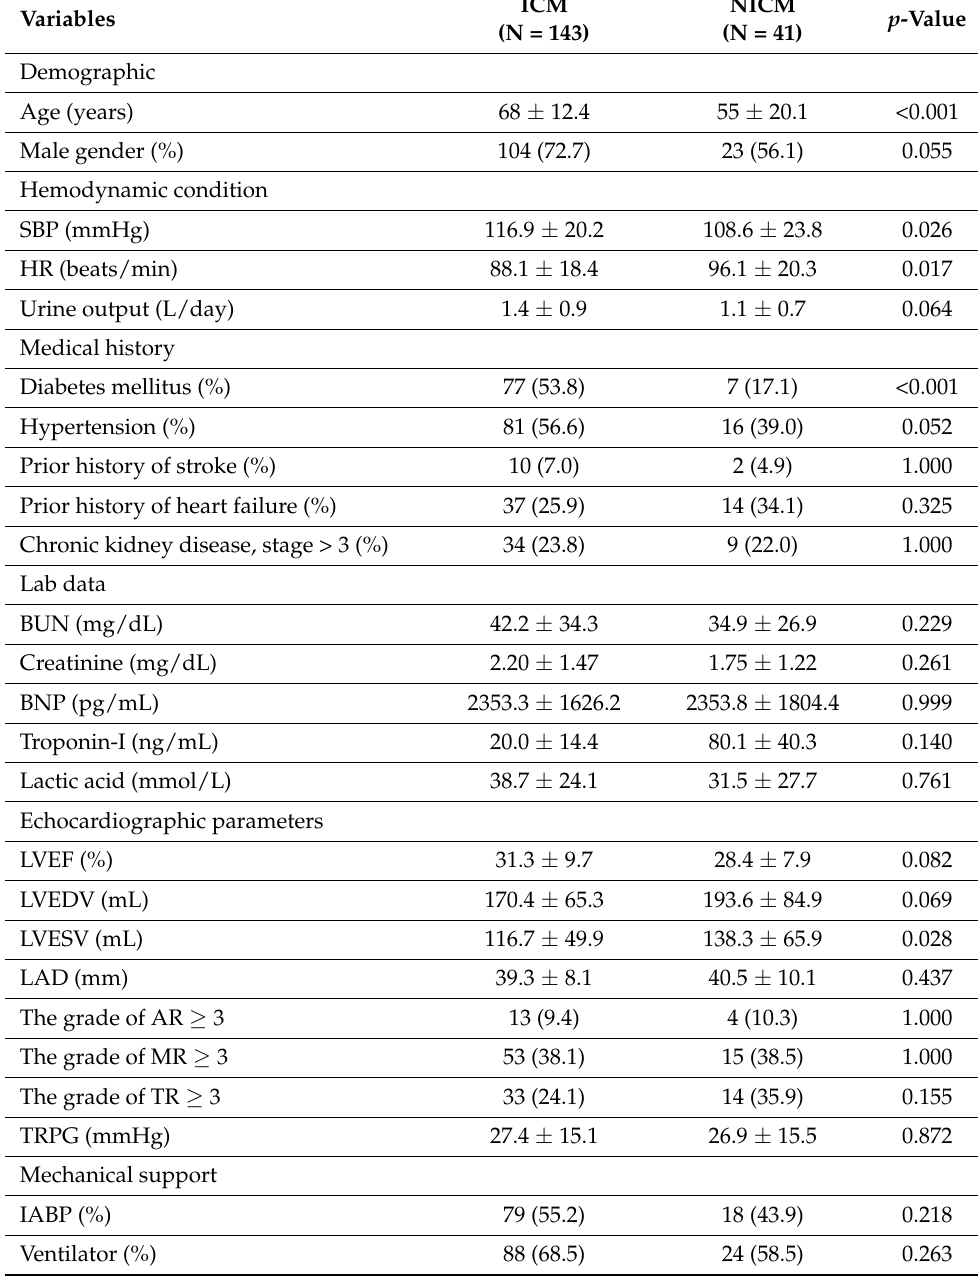
Table 1. Demographics and clinical